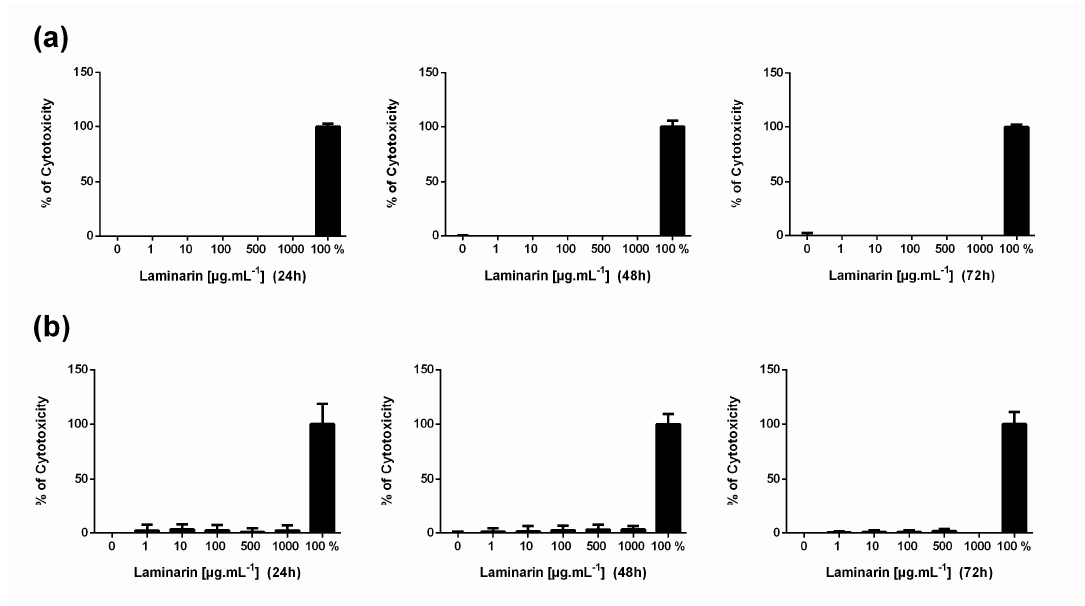
Figure 3. Evaluation of cell cytotoxicity by the LDH cytotoxicity assay. HDFa ( a ) and NHEK cells ( b ) were stimulated with 1, 10, 100, 500 and 1000 µg.mL − 1 laminarin for 24 h (left), 48 h (middle) and 72 h (right) and cell cytotoxicity was performed using a tetrasodium salt (INT). Data are expressed as mean ± SD of three independent experiments.